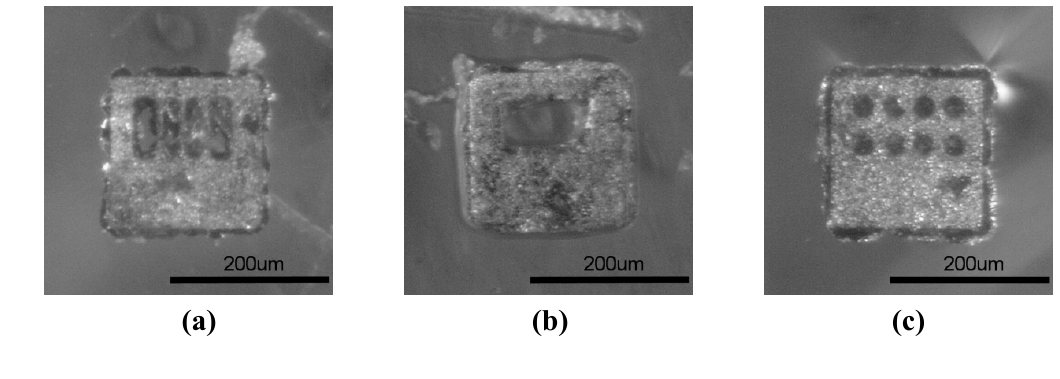
Figure 7. Ferromagnetic coded micro-carriers with different codes: (a)